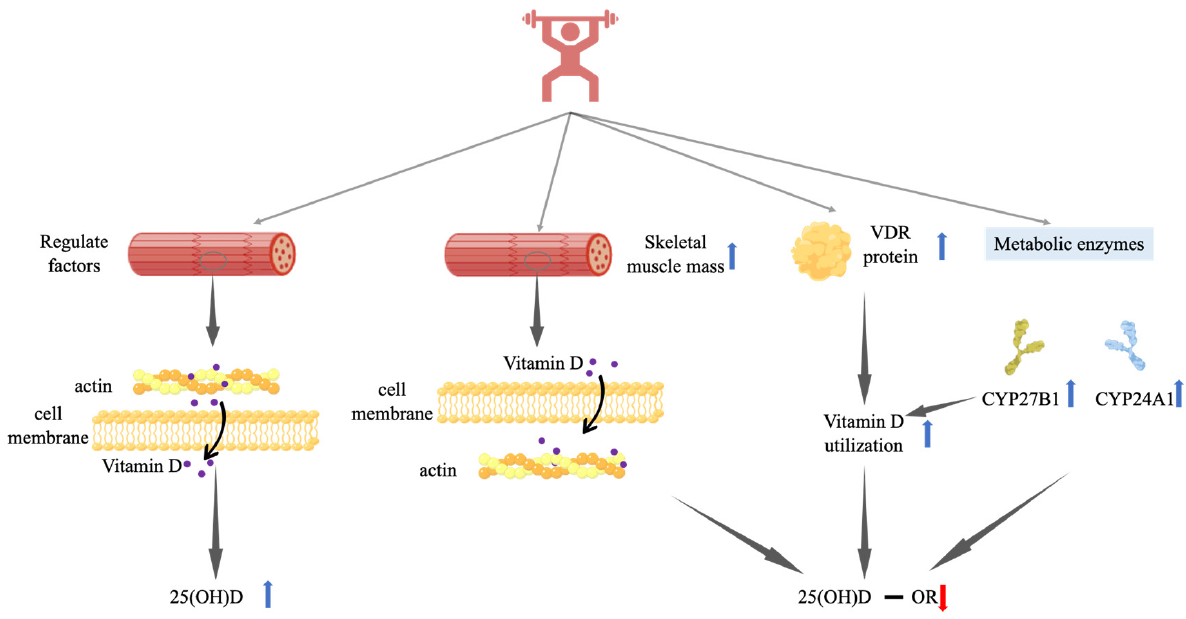
Figure 2. Possible mechanisms of the effect of resistance training on serum 25(OH)D. Vitamin D indicates serum vitamin D metabolites; − indicates no significant change; ↑ indicates significant increase; and ↓ indicates significantly reduction. Regulation factors include VDR, PTH, DBP, and vitamin D nutritional status. 25(OH)D-1 α hydroxylase, CYP27B1, can convert 25(OH)D to 1,25(OH) 2 D. Vitamin D 24-hydroxylase, CYP24A1, is an important degrading enzyme of vitamin D. Abbreviations: VDR, vitamin D receptor.